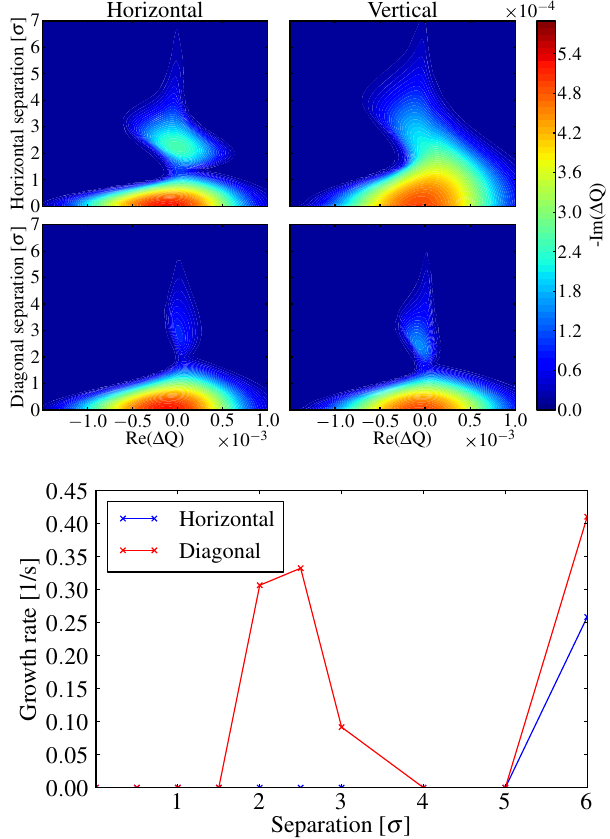
FIG. 11. Stability diagram (above) and simulated growth rate with weak-strong tracking (below), while collapsing the separa- tion in one IP, in two configurations. In the first, the separation is in the horizontal plane, in the second on the diagonal, i.e., the separation is equal in the vertical and horizontal plane. The machine and beam parameters are those of 2012, without the beam is stable for separations below 5 σ . Above this value, the beam is unstable in both configurations, as the tune spread due to the single beam-beam interaction becomes negligible at large separation.